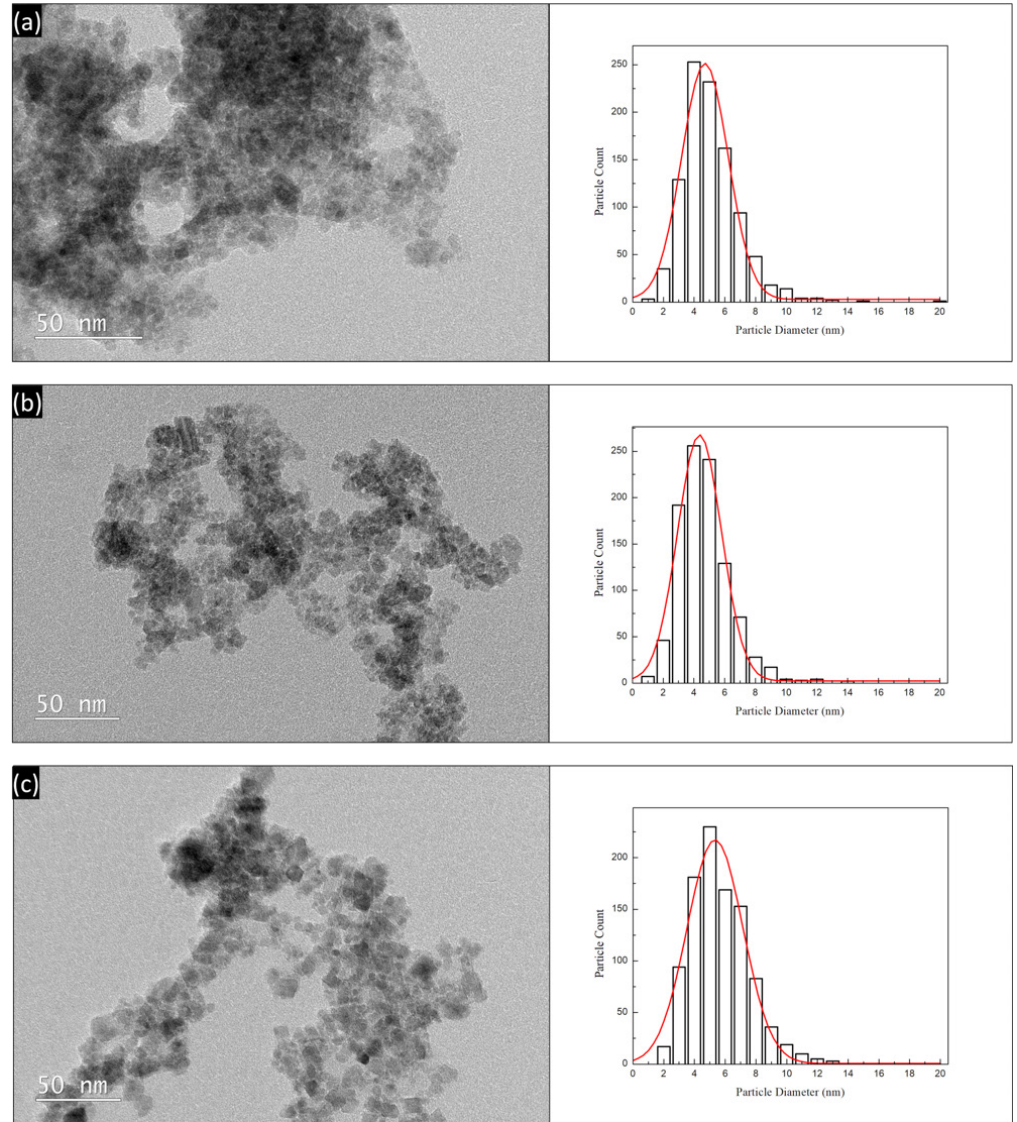
Fig. 2. TEM bright field micrographs (left) and size distribution histograms with Gaussian distributions in red (right) of the L-glutamine series of capped nanoparticles, being PreQ (a), SimQ (b) and PostQ